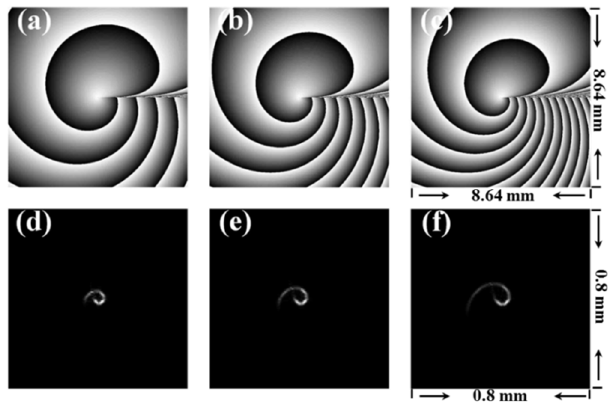
Figure 1. ( a – c ) The phase profiles encoded with Equation (1) with l = − 5 and n = 0.4, 0.5, 0.6, respectively. ( d – f ) The focal fields of the generated exponential beams with the phase profiles shown in ( a – c ), respectively.